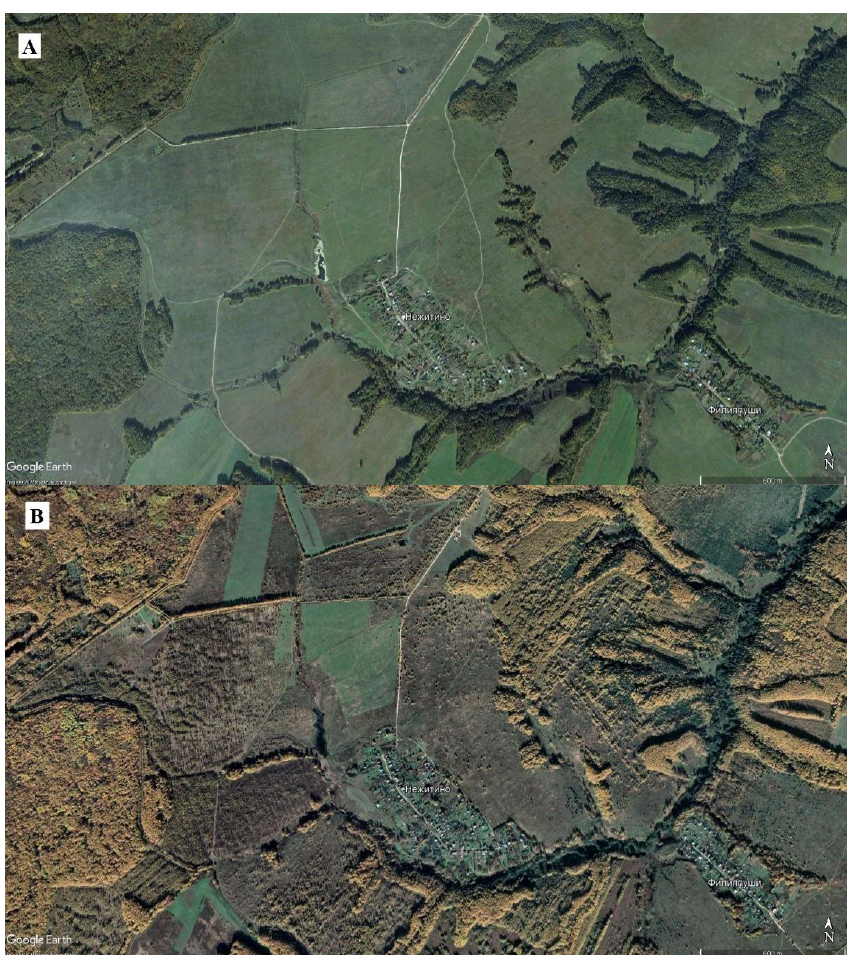
Figure 3. Examples of overgrowth nearby (space images of the Earth ’ s surface, Google Earth Pro V.